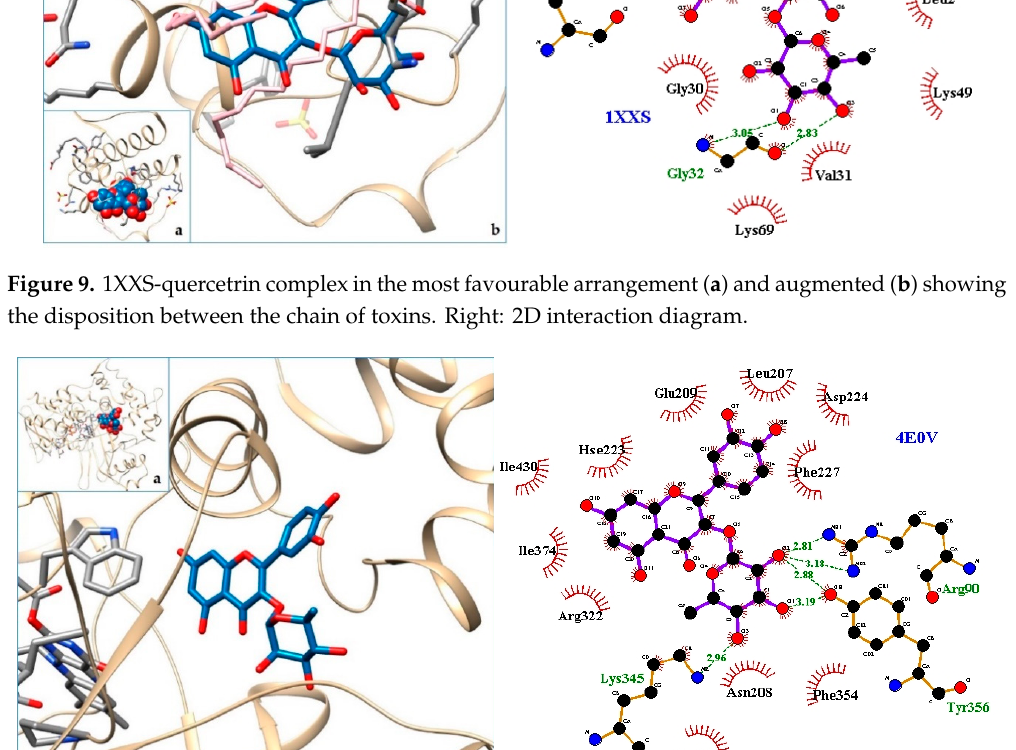
Figure 10. 4E0V-quercetrin complex in the most favourable arrangement ( a ) and augmented ( b ) showing the disposition between the chain of toxins. Right: 2D interaction diagram.